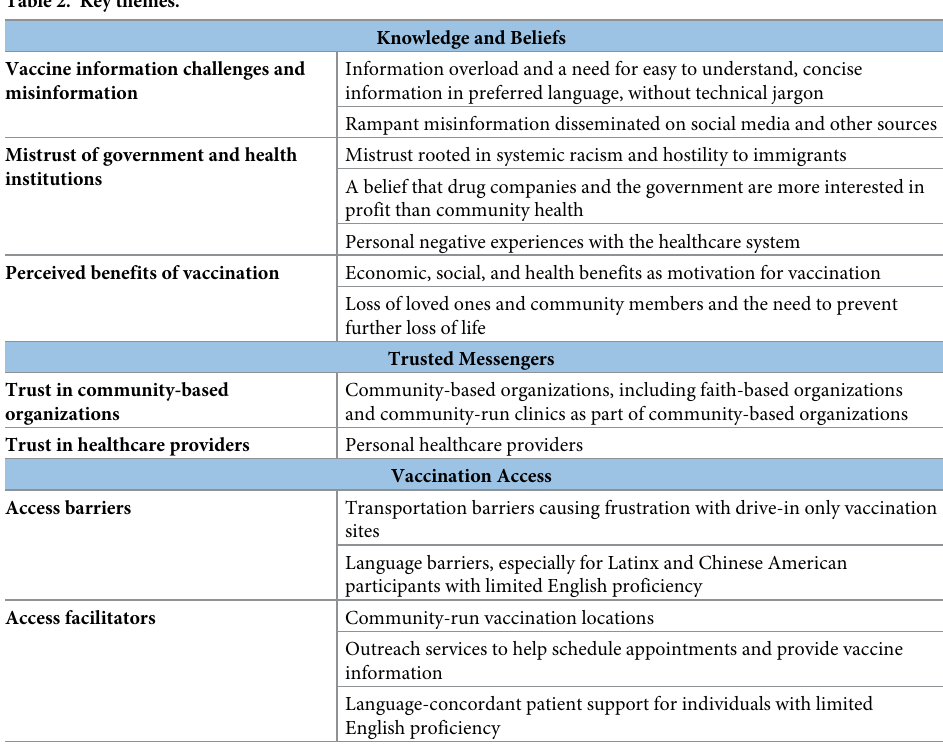
Knowledge and Beliefs